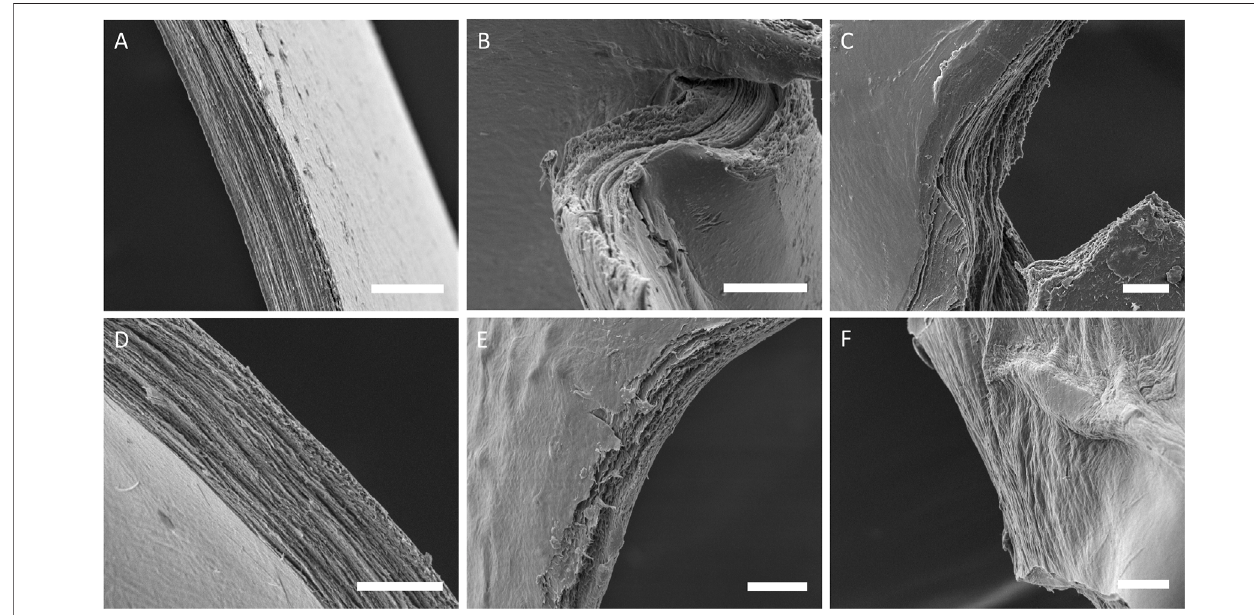
FIGURE8 | SEM images of cross-sections from sample groups, (A) col-I 3 mg/ml A, (B) col-II 3 mg/ml A, (C) col-II 6 mg/ml A, (D) col-I 3 mg/ml B, (E) col-II 3 mg/ ml B, and (F) col-II 6 mg/ml B.